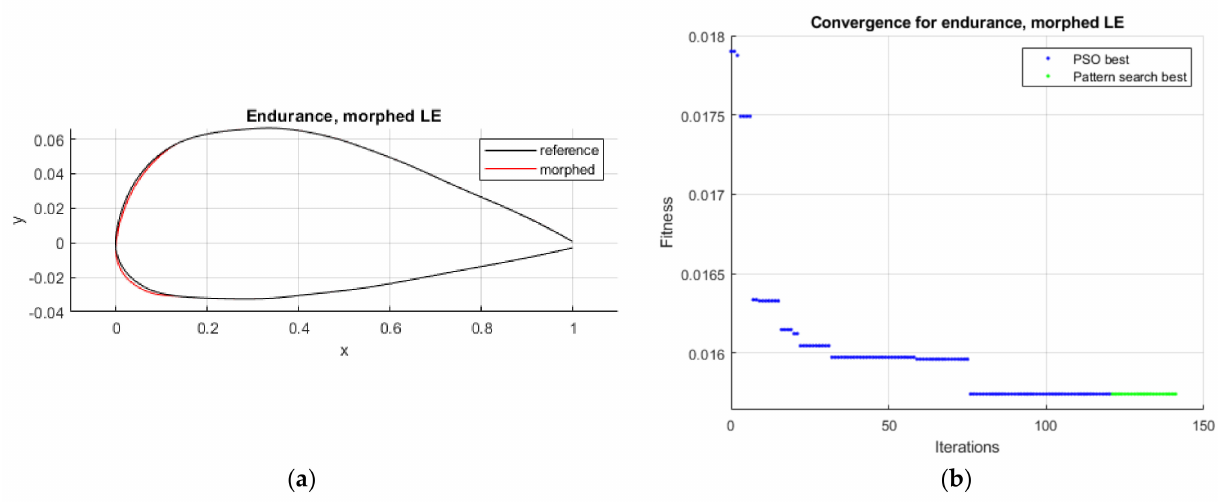
Figure 16. Optimized airfoil and convergence history for endurance maximization function. ( a ) the initial (reference) versus the final (optimized or morphed) airfoil shape; ( b ) the convergence for aerodynamic endurance optimization.